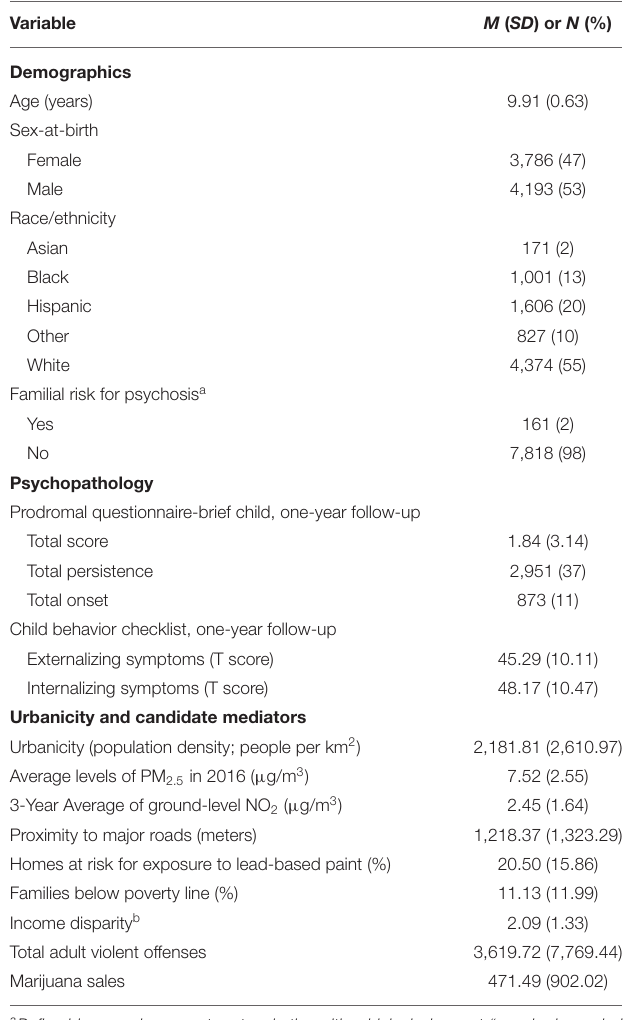
TABLE 1 | Participant characteristics and variable